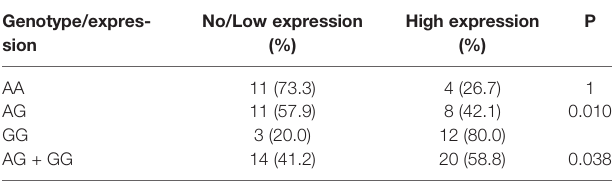
No/Low expression High expression (%) (%)